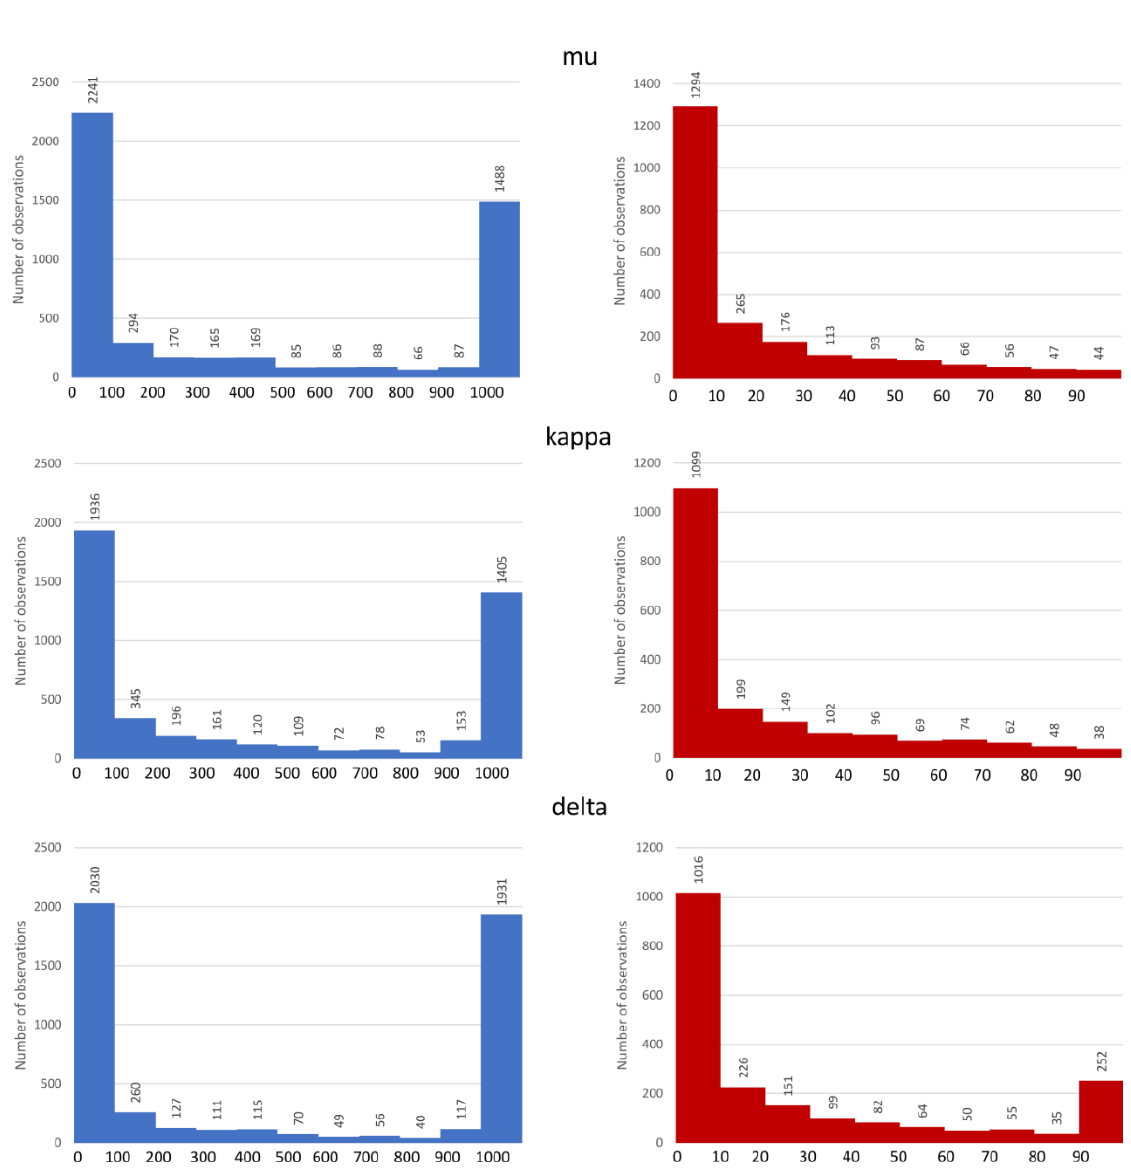
Figure 1. Distribution of K i values of opioid receptors ligands, full data are depicted in blue, red bars refer to the activity distribution of the most active ligands (K i < 100 nM).